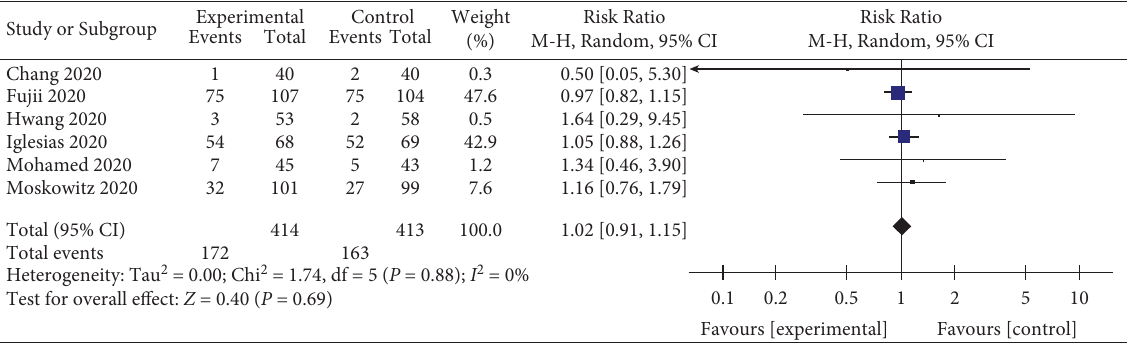
Figure 11: Forest plots for the efects of vitamin C on the new onset of